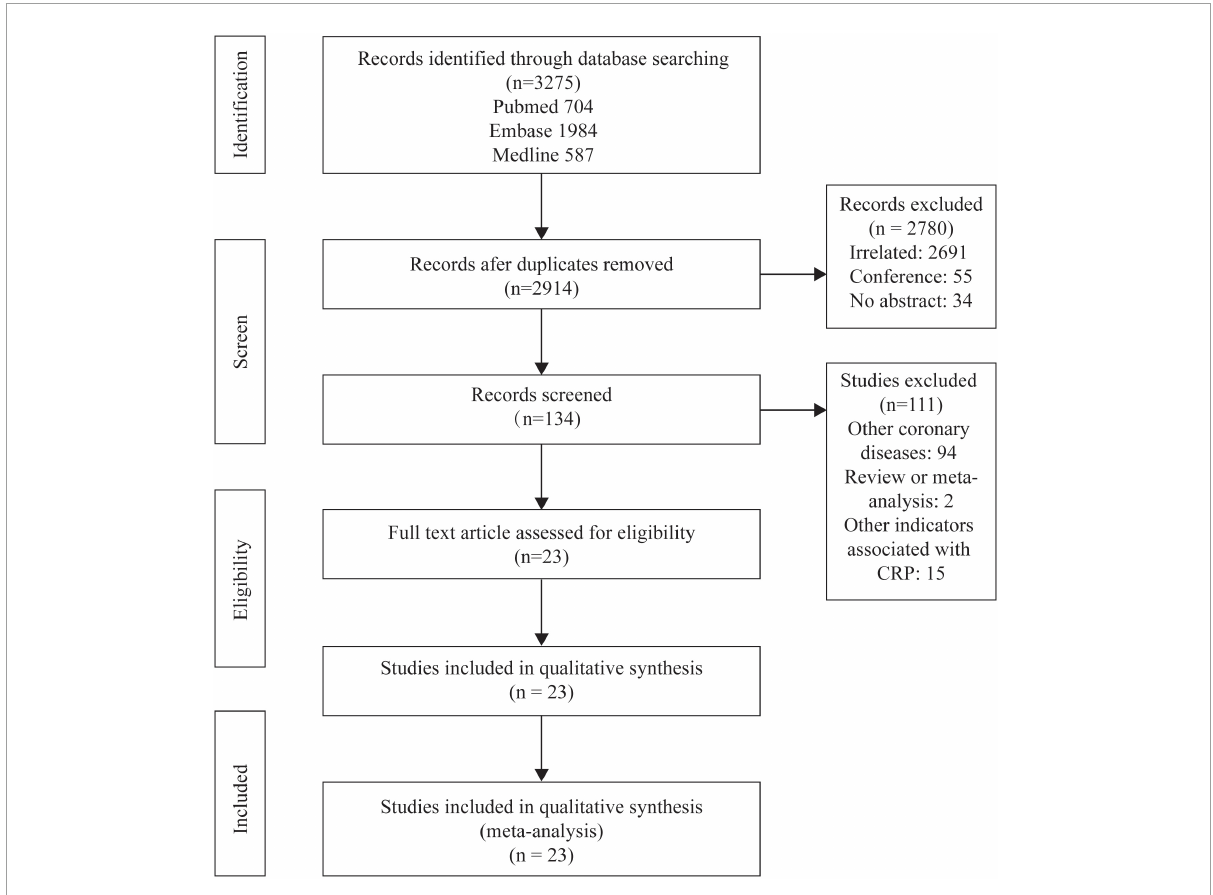
FIGURE1 Flowcharts showing relevant